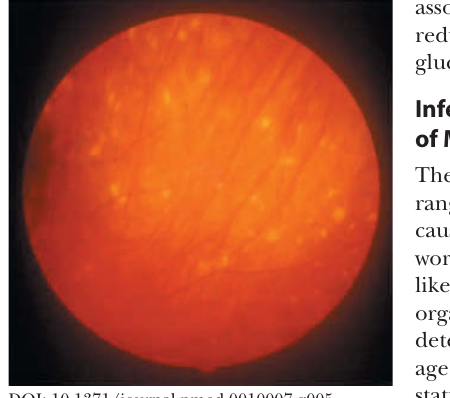
Figure 5. Scarring When Choroidal Granulomas